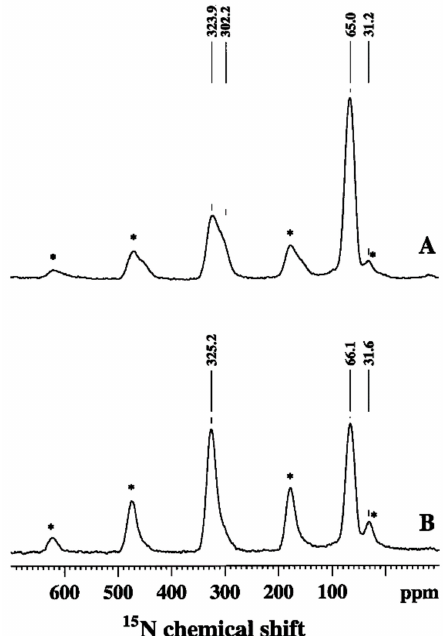
Figure 3. 15 N CP / MAS spectra of the 15N labeled PANI before ( A ) and after ( B ) reaction with DPPH. The asterisks denote spinning sidebands. Reprinted with permission from reference [28]. Copyright (2006) Elsevier.